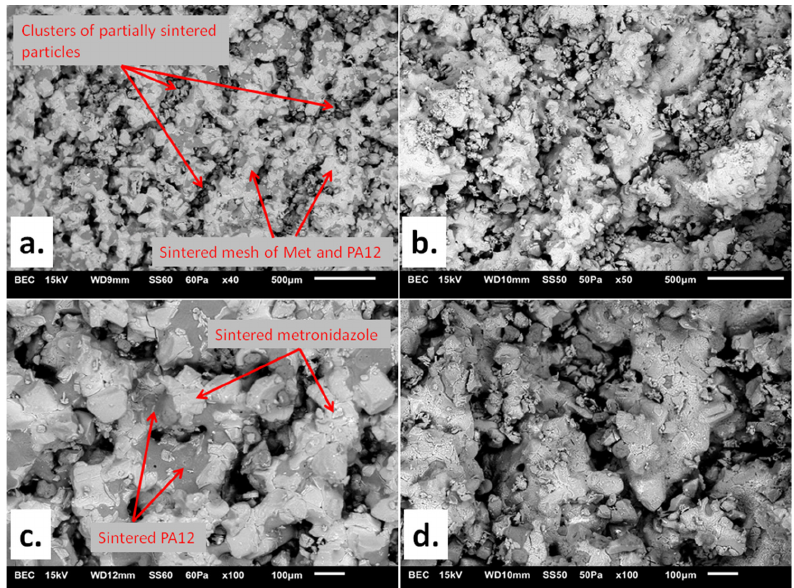
Figure 2. SEM images of ( a ) Formulation A (80/20/0/100) at 40× magnification; ( b ) Formulation D (90/10/0/75) at 50× magnification; ( c ) Formulation A (80/20/0/100) at 100× magnification; ( d ) Formulation D (90/10/0/75) at 100× magnification. The markings are commented on in the text.